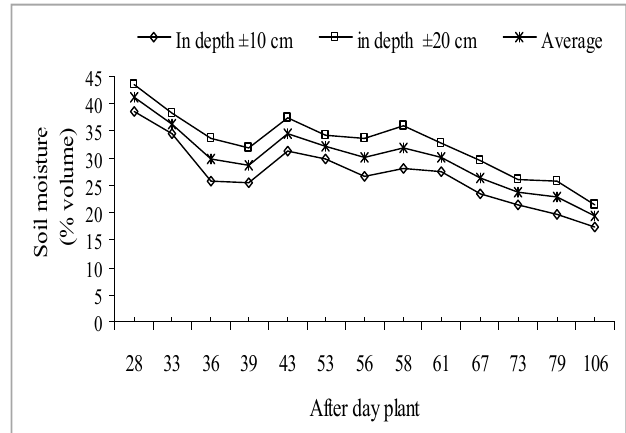
Figure 1: Moisture of soil during the trail in rain-fed lowland rice of Sanca Village, District Gantar, Indramayu, Indonesia, from April to July in 2012.